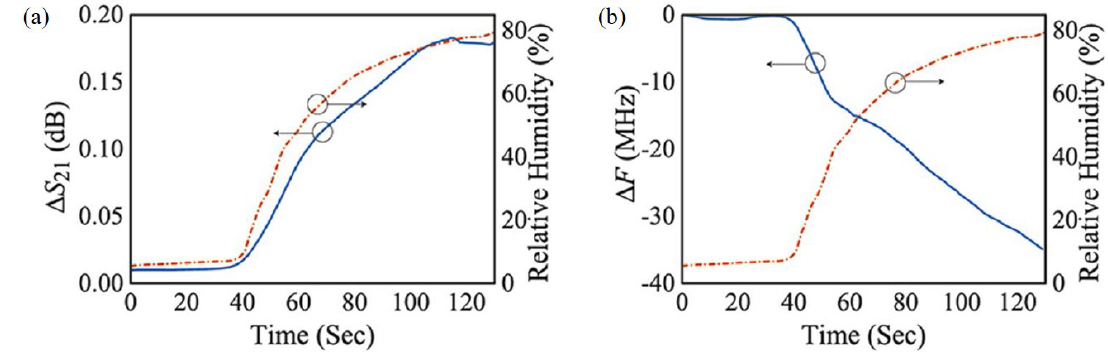
Figure 15. Measured results of the sensor. ( a ) Variation in transmission coefficient with change in relative humidity. ( b ) Variation in resonant frequency with change in relative humidity